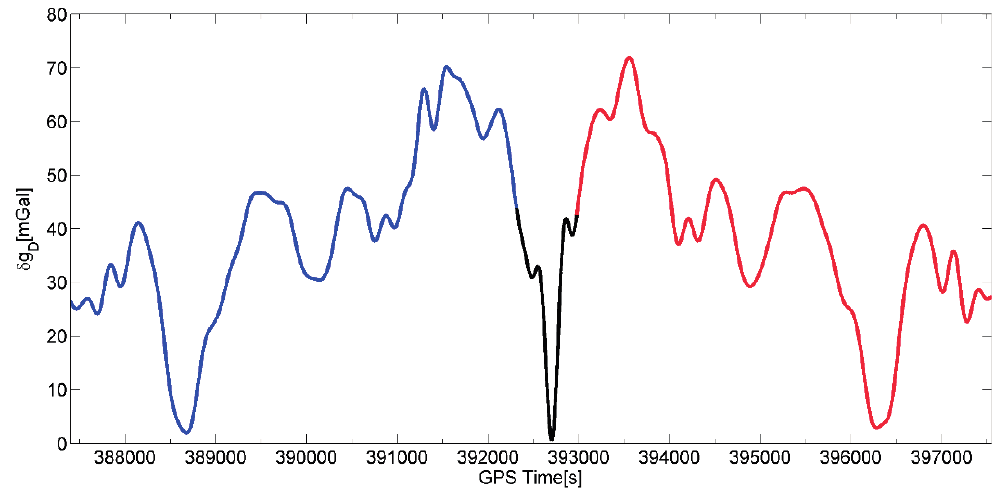
Figure 6. Filtered gravity disturbance along the primary repeated flight A. The northbound flight is shown in blue while the southbound one is marked in red. The black curve between time 392,000 s and 393,000 s represents a 360° turn of the